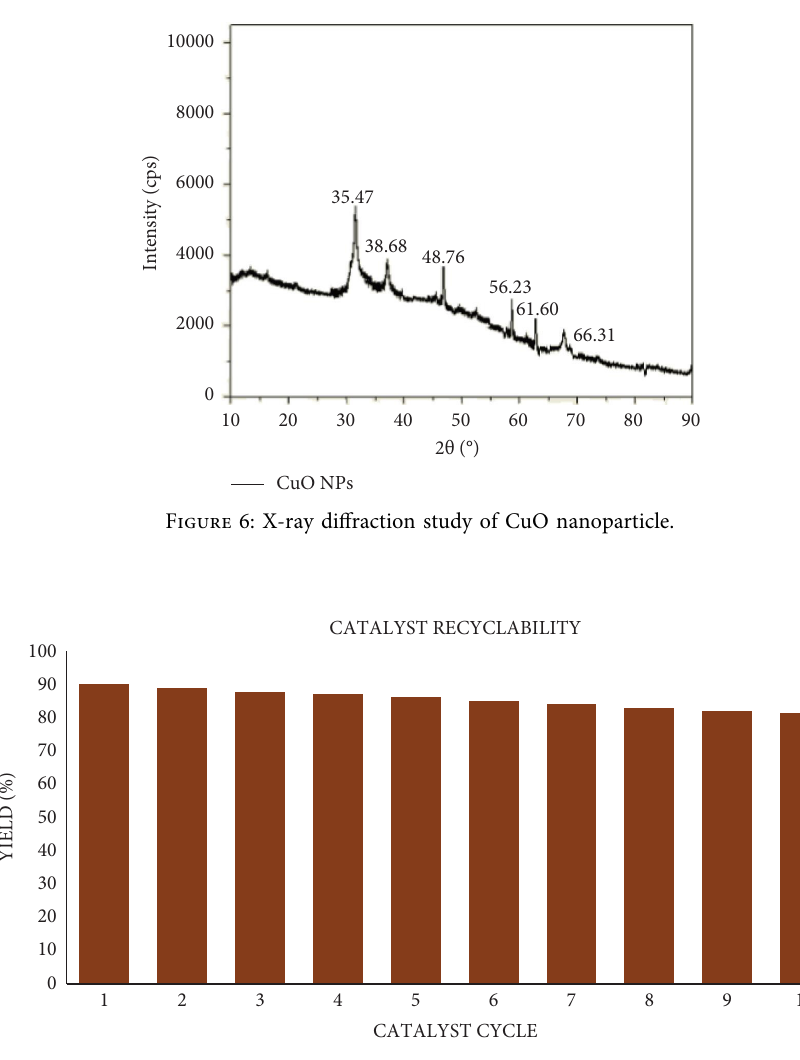
Figure 7: Recyclability of CuO nanoparticles.